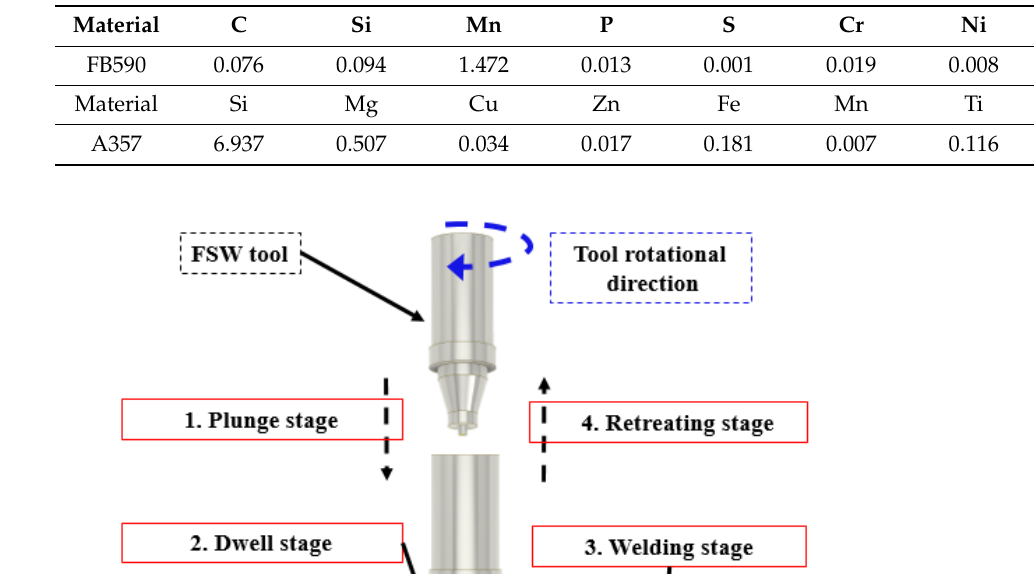
Table 1. Chemical composition of FB590 (high-strength steel) and A357 (cast Al) pipes [9].